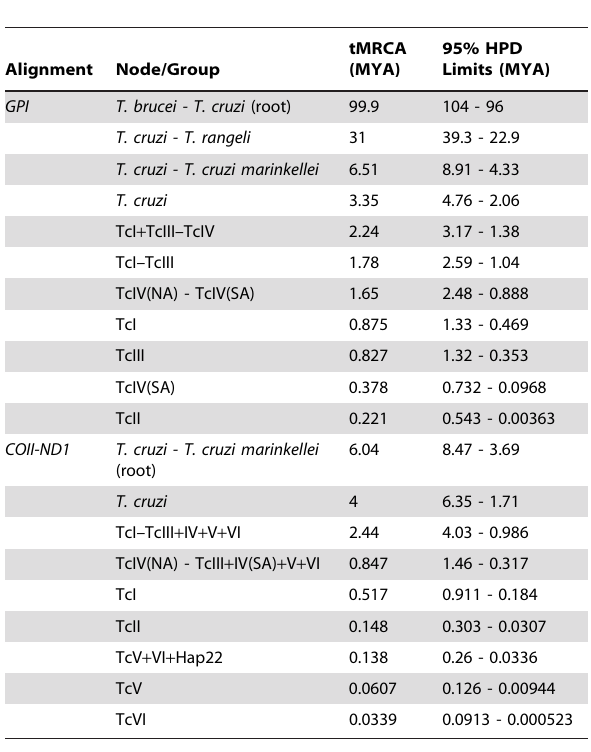
Table 3. Divergence times for selected species and T. cruzi